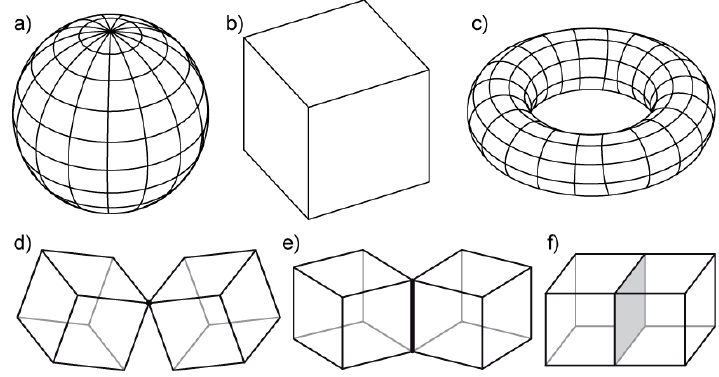
Figure 1. Two-manifolds and non-manifolds: the surface of (a) a sphere; (b) a cube; (c) a torus is a two-manifold; two cubes joined by (d) a vertex; (e) an edge; (f) a face form a non-manifold object.